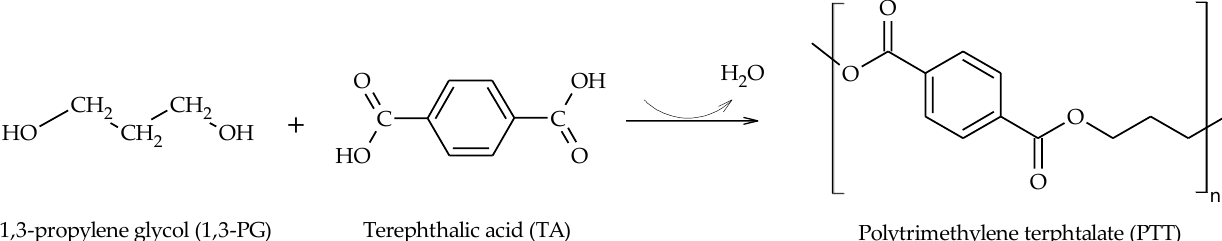
Scheme 4. The polymerization of 1,3-PG in the presence of terephthalic acid to produce PTT. About 21% of the 1,3-PG market is used in the manufacture of polyurethane (PU), which is used to make elastomers and plastics. It is also used in the manufacture of cos- metics (14%), as an antifreeze fluid (9%), in the manufacture of cleaning products (8%), and as a heat exchange fluid (6%). Other applications (12%) include its use as an interme-